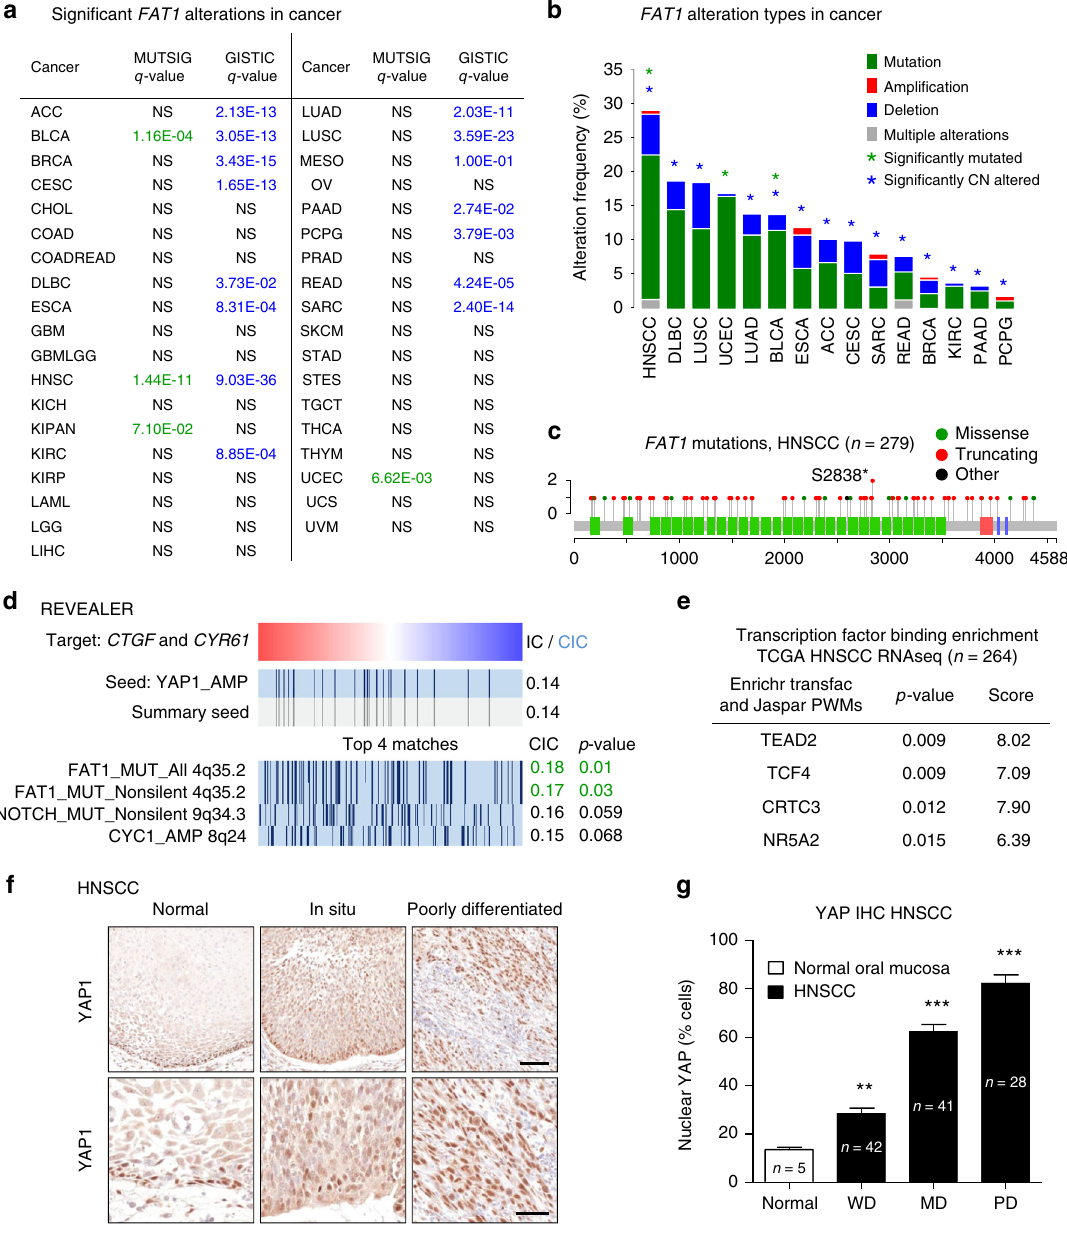
Fig. 1 Frequent alterations of FAT1 are linked to YAP1 overactivity in cancer. a Analysis of FAT1 alterations in human malignancies. The signi fi cance of FAT1 alterations in a panel of common human malignancies was analyzed by the MUTSIG and GISTIC methods. NS: not signi fi cant. See abbreviations and number of cases analyzed for each cancer type in Supplementary Fig. 1. b Graphical representation of cancer types in which FAT1 is most frequently altered. c Analysis of FAT1 mutations in 279 fully characterized HNSCC samples from TCGA. d REVEALER analysis on the TCGA HNSCC RNASeq dataset ( n = 504) was used to identify genomic abnormalities that negatively correlate with YAP1 ampli fi cation and increased expression of the YAP1 targets CTGF and CYR61 . e Enrichment analysis of transcription factor binding sites on upregulated genes in HNSCC samples harboring FAT1 and FAT2 alterations. f YAP1 immunohistochemistry depicting the increase of expression levels and nuclear localization (activation) during HNSCC disease progression. Scale bar upper panels, 100 µ m, lower panel, 50 µ m. g YAP1 staining quanti fi cation. WD, well differentiated; MD, moderately differentiated; PD, poorly differentiated. Bars represent average plus standard error of the mean (SEM). ** P < 0.01, *** P < 0.001 (One-way